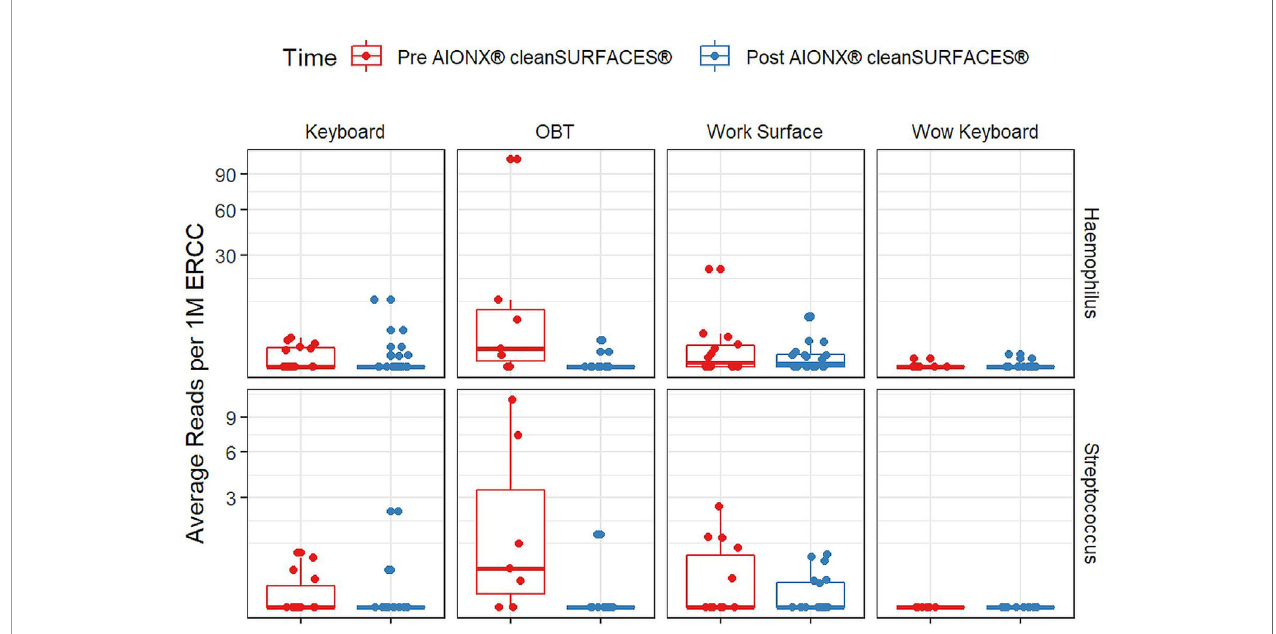
FIGURE 7 | Normalized average transcript count comparison boxplot of “ Respiratory Pathogens ’’ between surfaces before and after the intervention of the AIONX ® cleanSURFACES ® . Statistically signi fi cant (adjusted p < 0.05) comparisons are marked with an